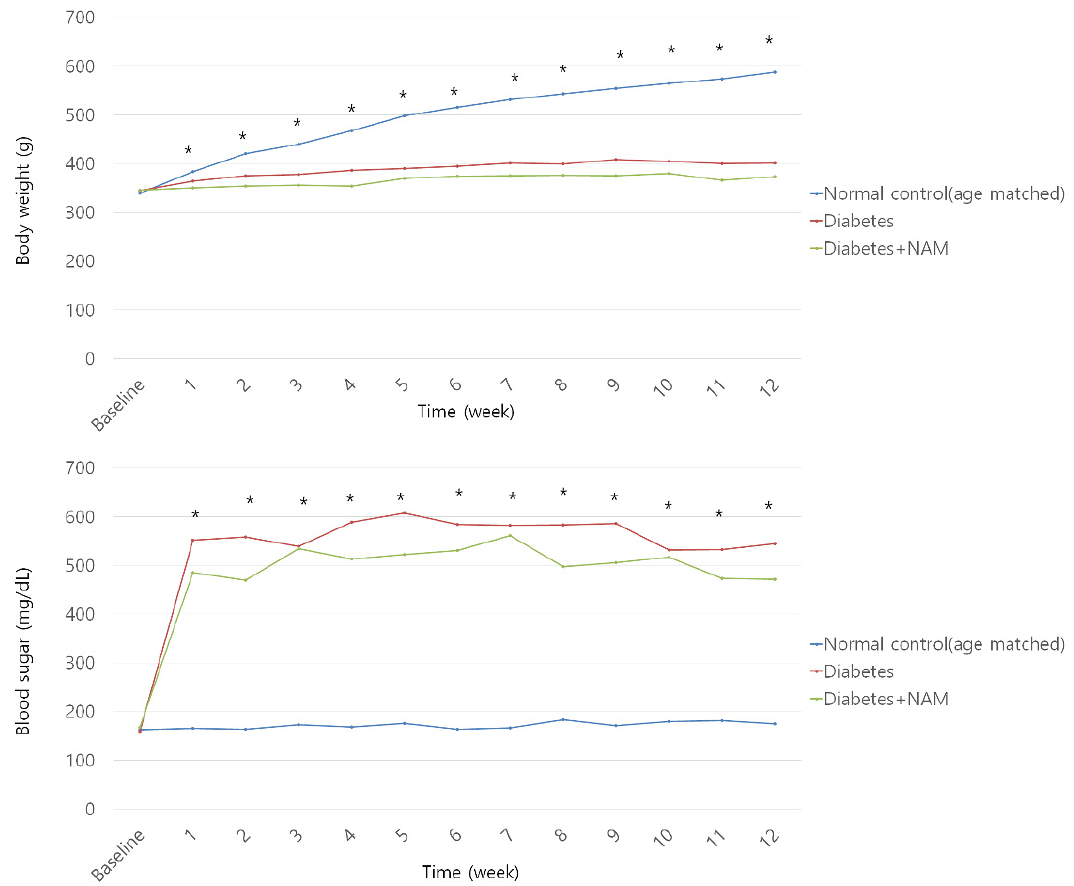
Figure 3. Body weight and blood glucose level. Body weight was lighter in the diabetes group than in the normal control group from one week to twelve weeks after streptozotocin injection, regardless of drug treatment (all p < 0.05). Blood glucose was elevated in the diabetic rats compared to the normal control rats from one week to twelve weeks after onset of diabetes (all p < 0.05). NAM, nicotinamide. *, significant difference exists between groups ( p < 0.05).